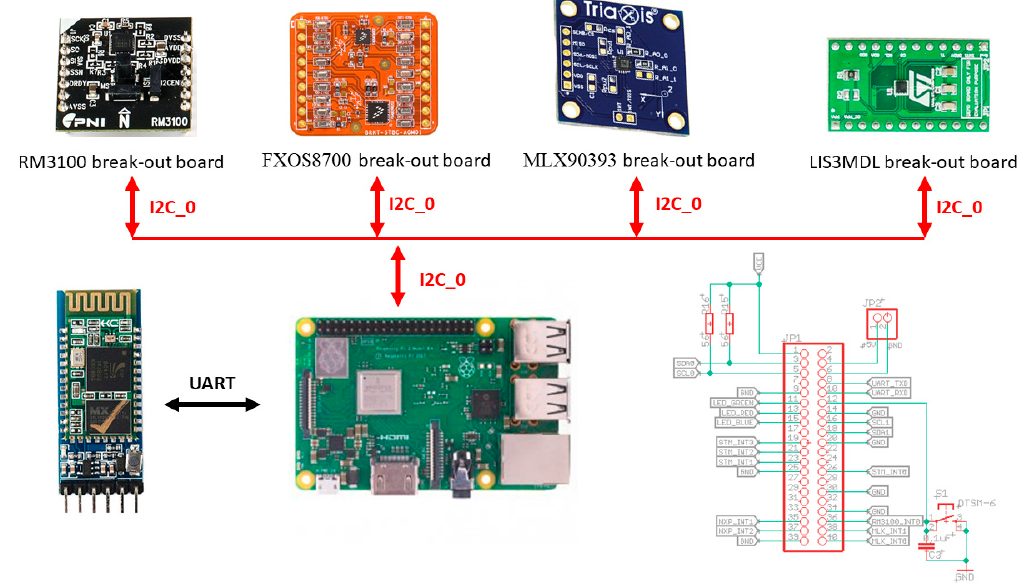
Figure 1. Block schematic of the developed measurement board.